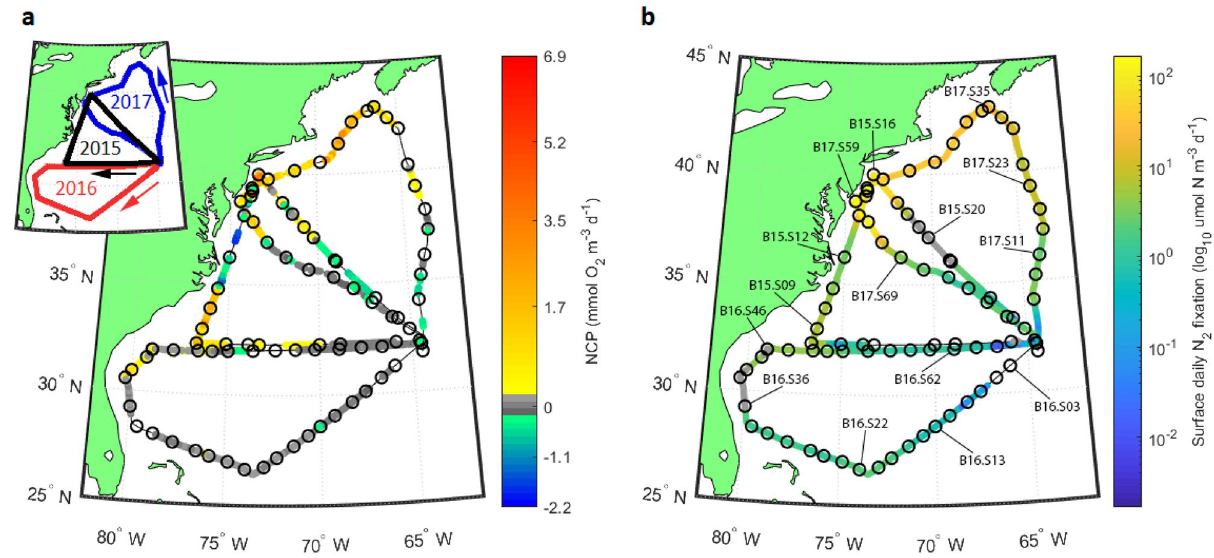
Figure 1. NCP and N 2 fixation rates. ( a) Map of O 2 /Ar-based volumetric NCP rates measured via EIMS across the Western North Atlantic in July–August 2015 36 , 2016, and 2017 37 . Positive rates are represented by the warm portion of the color scale, while negative rates are indicated using a cool color scale. Balanced NCP rates are shown in greyscale tones. Sites of molecular sampling are displayed by open circles. ( b) Map of surface daily N 2 fixation rates measured using the FARACAS method 22,37 . Sites of molecular sampling are displayed by open circles, with selected sites labeled. Greyscale points indicate sites at which N 2 fixation rates were below the limit of detection for the FARACAS method (0.19 µmol N m -3 day -1 ). Inset plot illustrates cruise tracks and directions of travel, color-coded for each year of sampling. Plots created using Matlab 2018b (https ://www.mathw orks. com/produ cts/matla